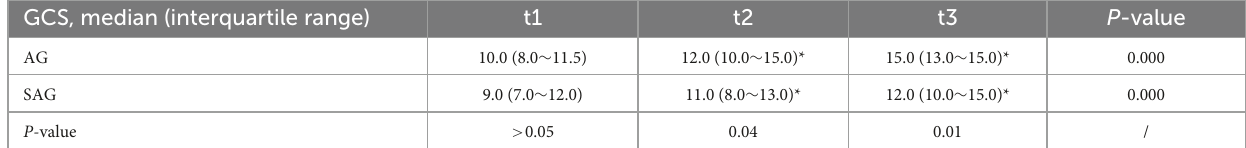
TABLE 4 GCS before and after